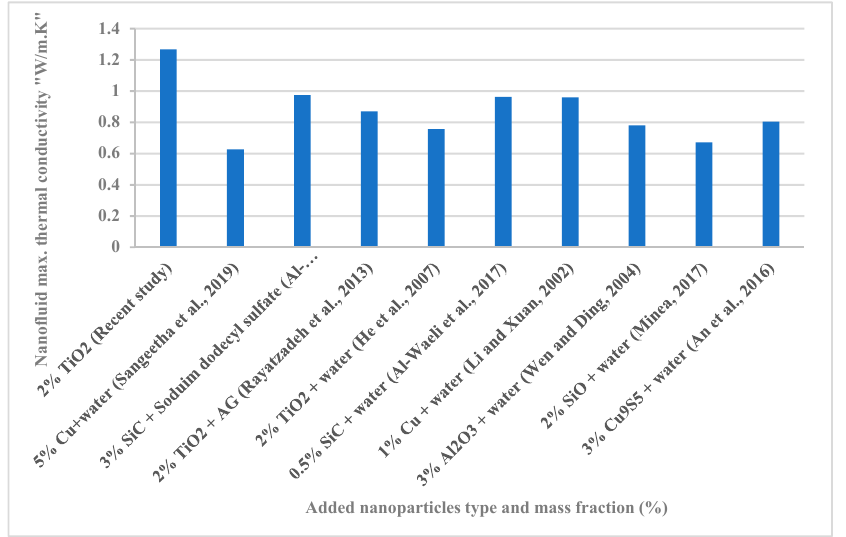
Figure 11. Comparison between the present study and other works in the literature, regarding